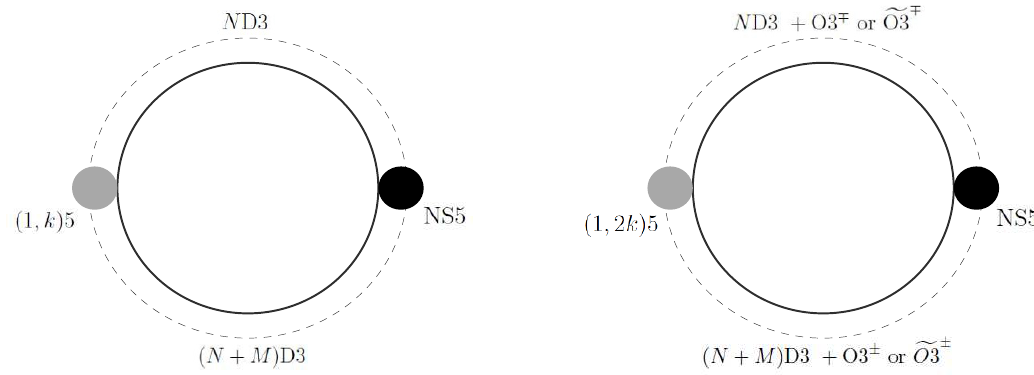
= 6 ABJ triality. N